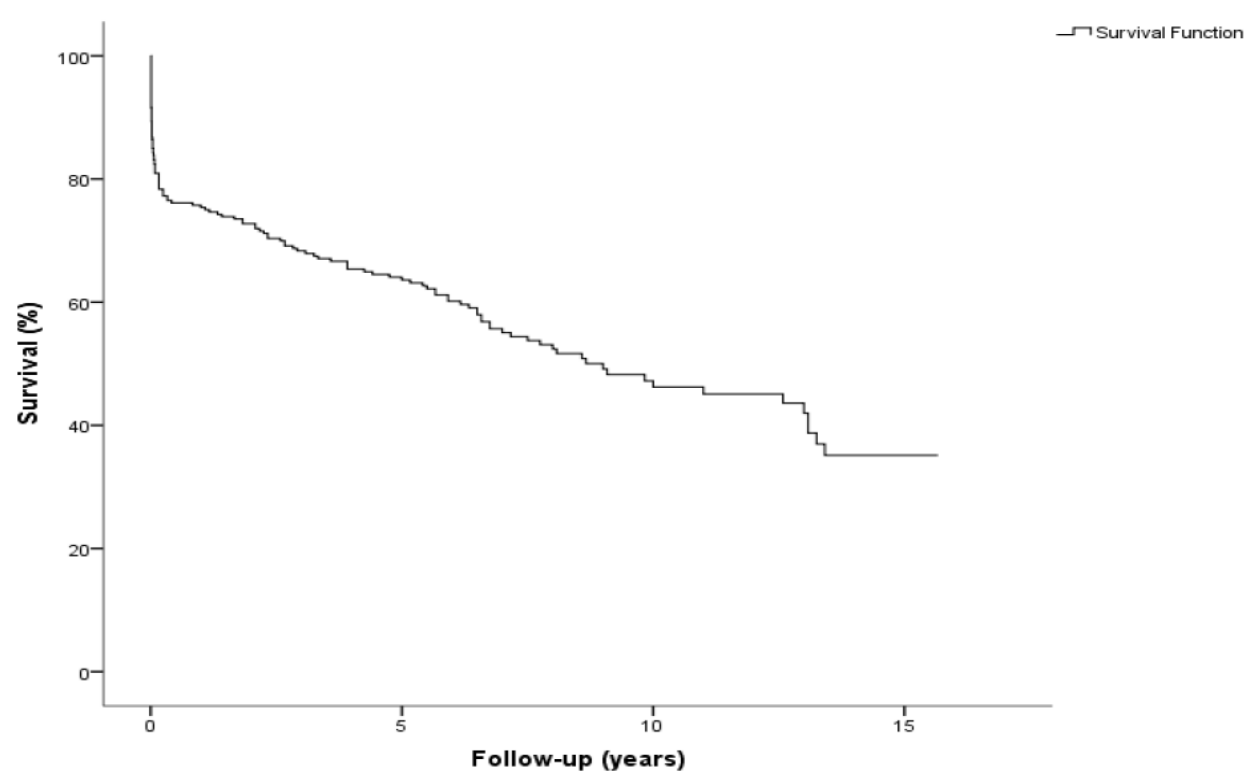
Figure 2. Kaplan–Meier curve showing overall survival after Bentall–De Bono operation.